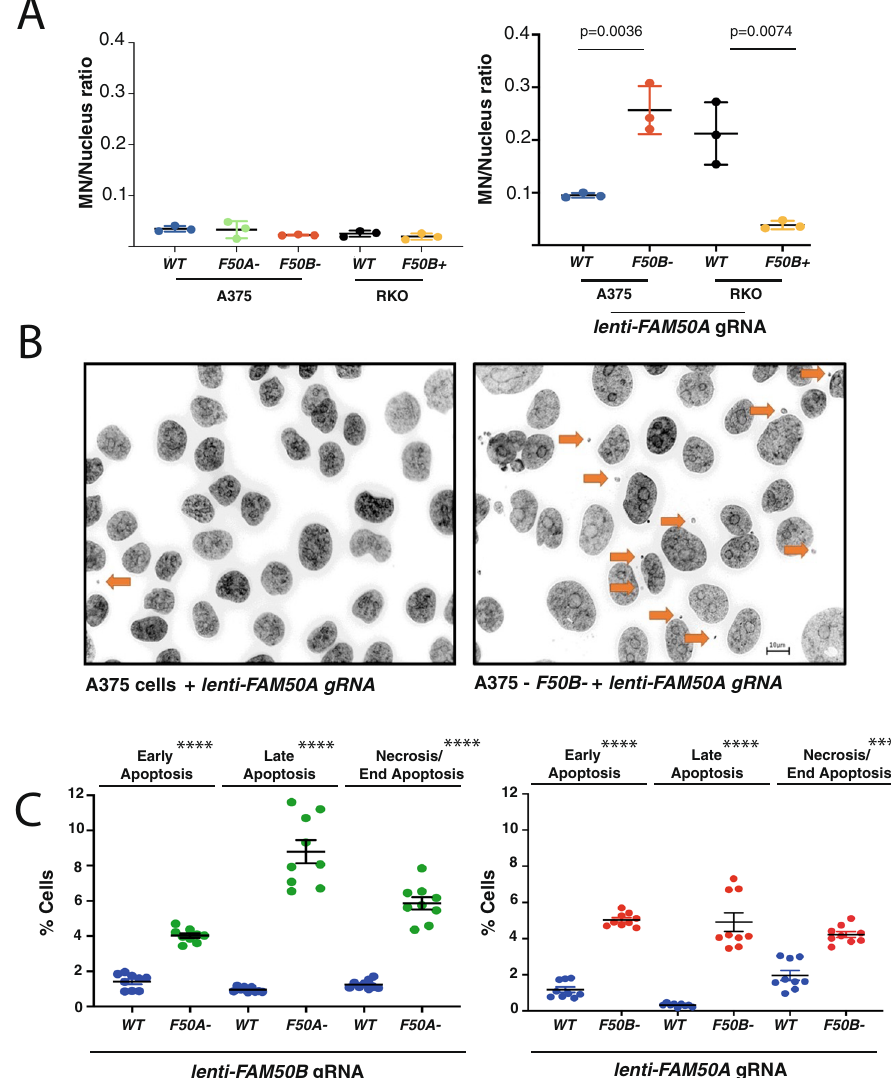
Fig. 5 Disruption of FAM50A/FAM50B results in micronucleus formation and apoptosis. A Micronucleus levels in wildtype (WT), FAM50A null ( F50A −